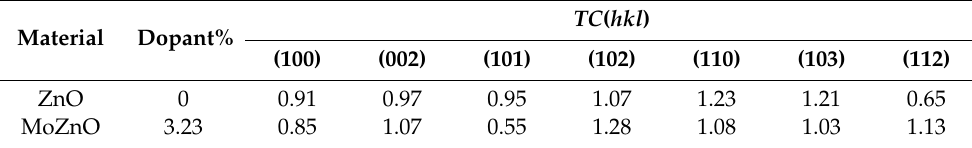
Table 3. Calculated texture coe ffi cients of MoZnO for the seven main peaks.